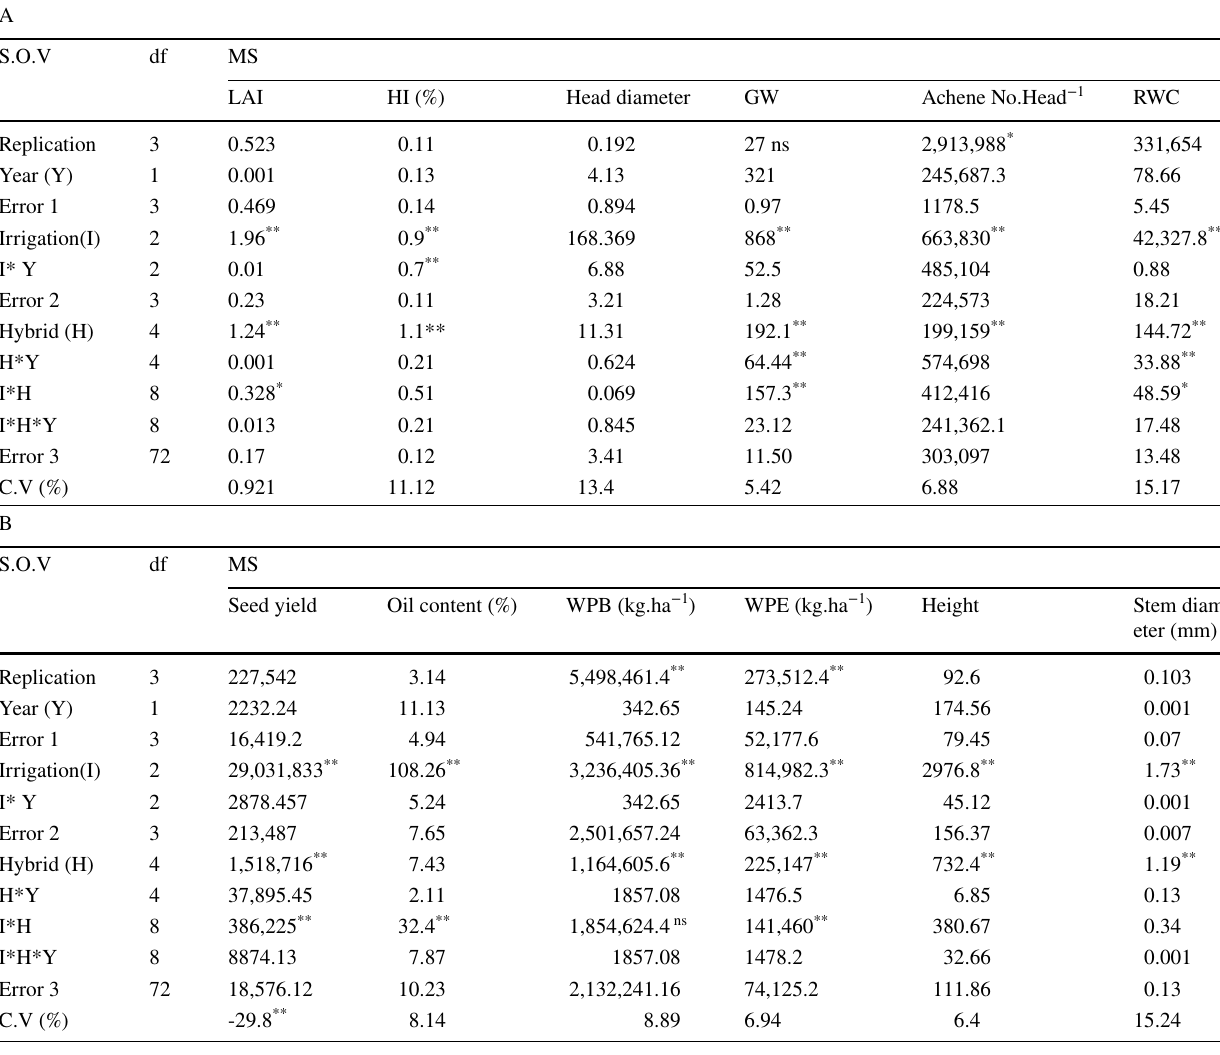
Table 3 Analysis of variance of studied characteristics in oil sunflower cultivars